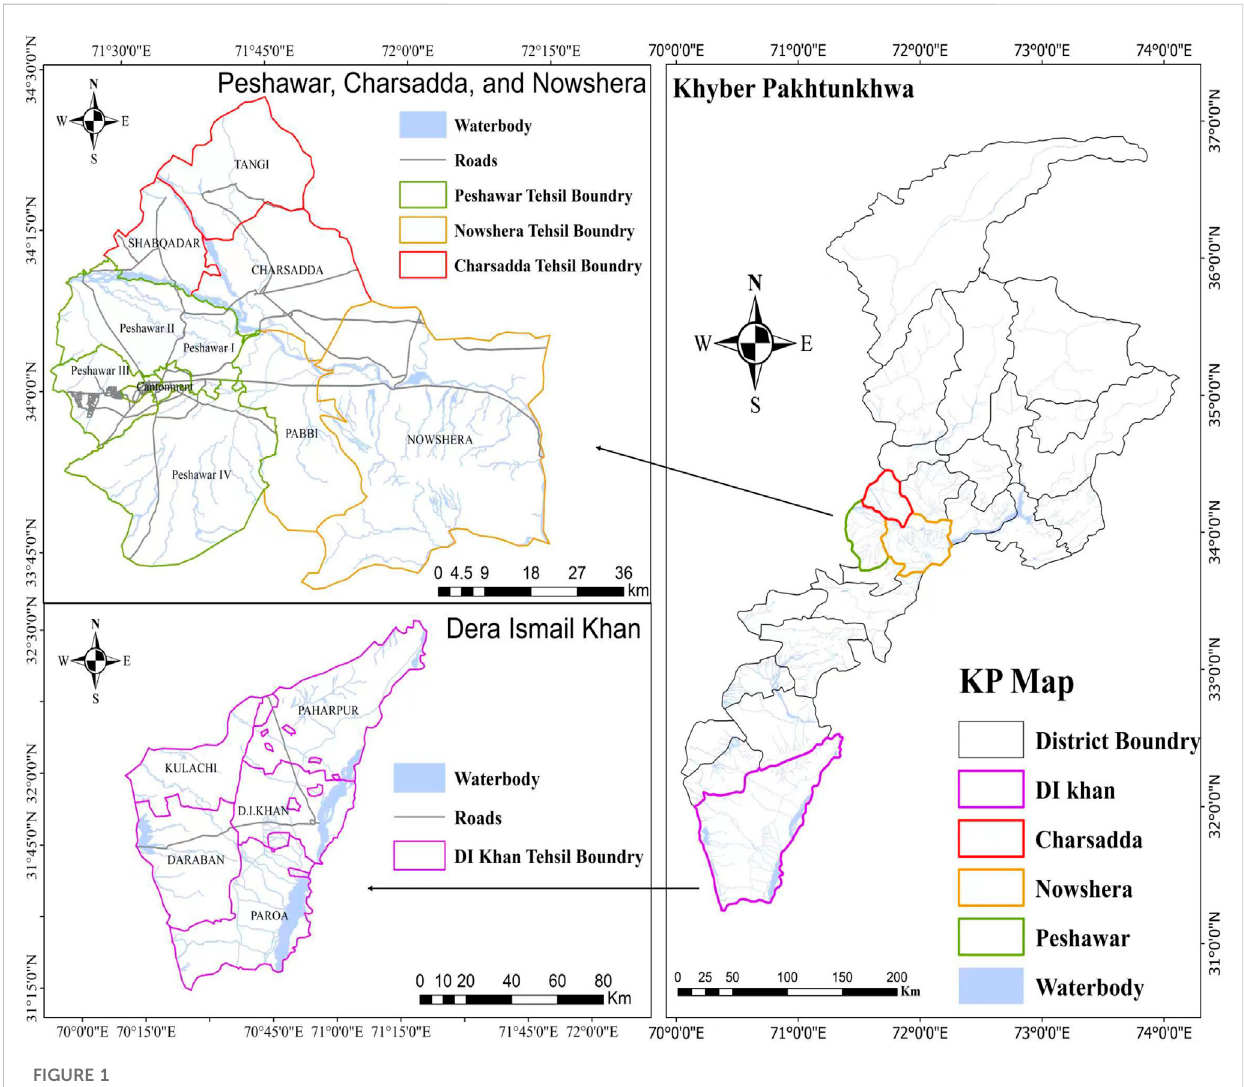
FIGURE 1 Sample study districts in Khyber Pakhtunkhwa Province,